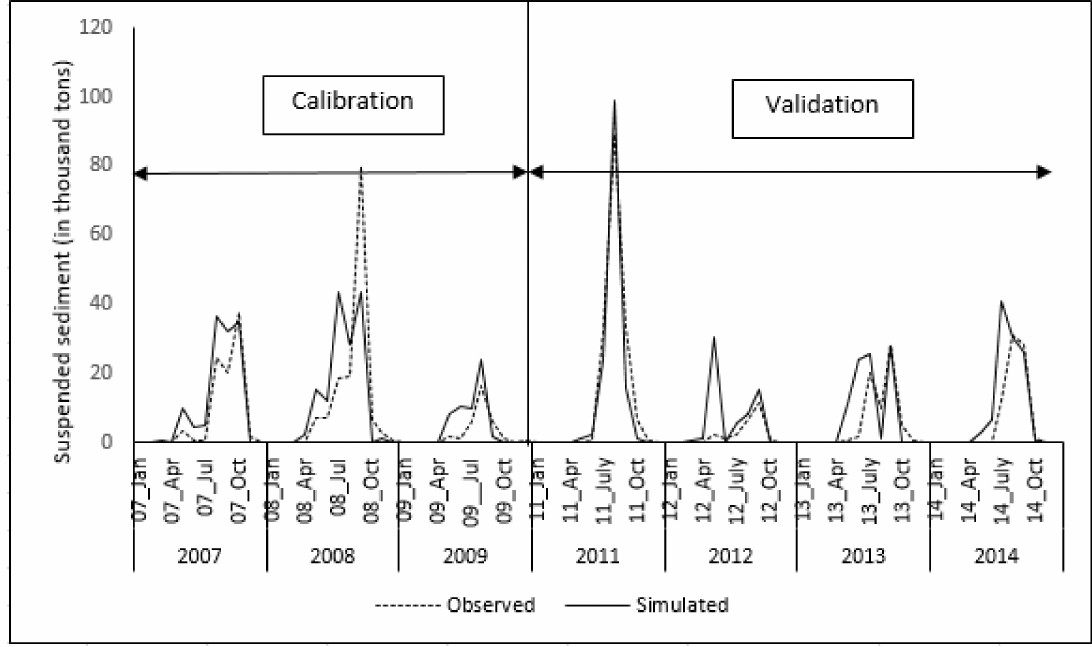
Figure 6. Monthly sediment calibration (2007–2009) and validation (2011–2014) at Station